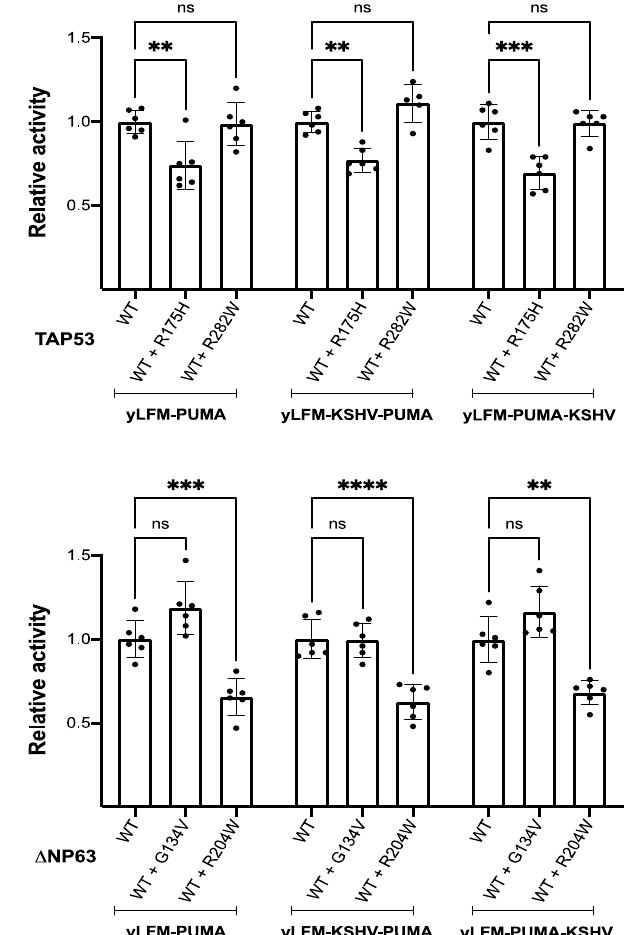
Figure 4. Relative activity of co-expressed wild-type and mutant TAP53 or ∆ NP63 proteins compared to the corresponding single protein expression. ( A ) Comparison of wild-type and mutant TAP53 co-expression activity (i.e., constitutive pADH1-wild-type TAP53 + inducible pGAL1,10 TAP53 R175H or R282W) with that of wild-type TAP53 expressed alone (i.e., constitutive pADH1-wild-type TAP53) in presence of the P53 RE from the PUMA target gene (yLFM-PUMA) or the same p53 RE along with a G4 prone sequence upstream (yLFM-KSHV-PUMA) or downstream (yLFM-PUMA-KSHV). ( B ) Comparison of wild-type and mutant ∆ NP63 co-expression activity (i.e., constitutive pADH1-wild-type ∆ NP63 + inducible pGAL1,10 ∆ NP63 G134V or R204W) with that of wild-type ∆ NP63 expressed alone (i.e., constitutive pADH1 wild-type ∆ NP63) in presence of the P53 RE from the PUMA target gene (yLFM-PUMA) or the same P53 RE along with a G4 prone sequence upstream (yLFM-KSHV-PUMA) or downstream (yLFM-PUMA-KSHV). WT, wild-type. ns: not significant, ** p < 0.01; *** p < 0.001; **** p < 0.0001.